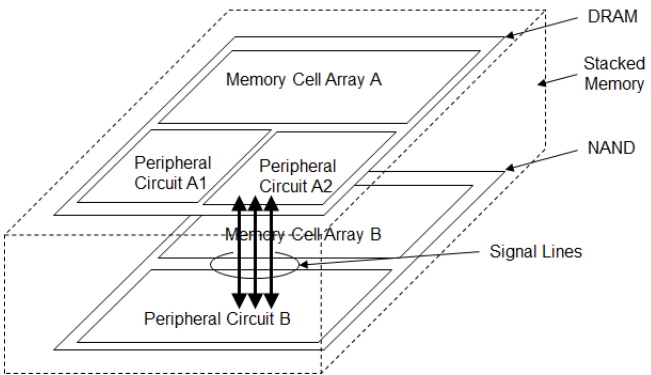
Figure 43. Future 3D stacked memory system [95].